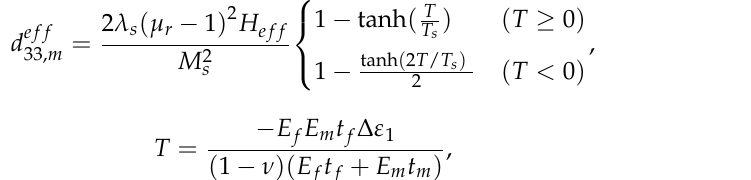
where λ s is the saturation magnetostrictive coefficient, µ r denotes the relative permeability, M s is the saturation magnetization intensity, T is the stress exerted on the Terfenol-D plate produced by the high-permeability film, T s is the saturation stress, E f and t f are, respectively, the elastic modulus and thickness of the high-permeability film, E m and t m are the elastic modulus and thickness of the Terfenol-D plate, respectively, ∆ ε 1 represents the strain of the high-permeability film, and ν is the Poisson’s ratio. The piezomagnetic constitutive equations for the Terfenol-D plate are given by [29]